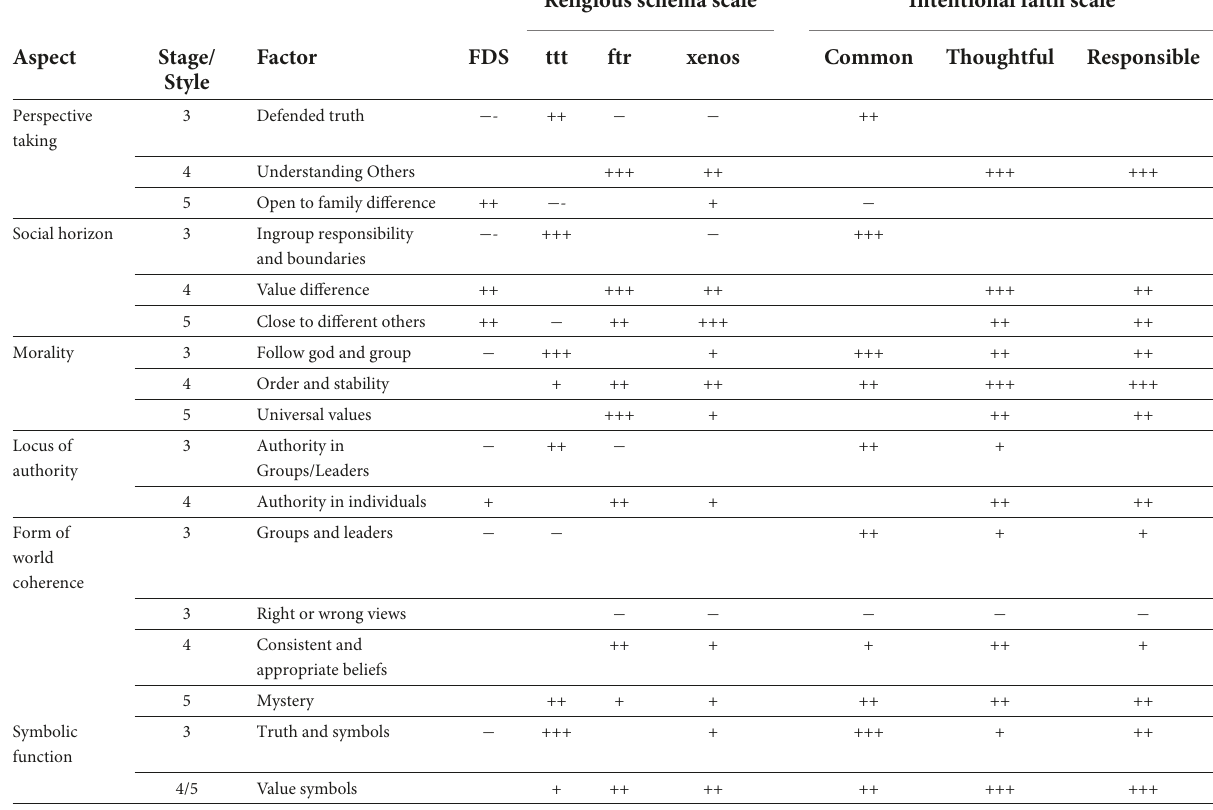
TABLE 3 Summary of significant correlations between factor scores and measures of faith